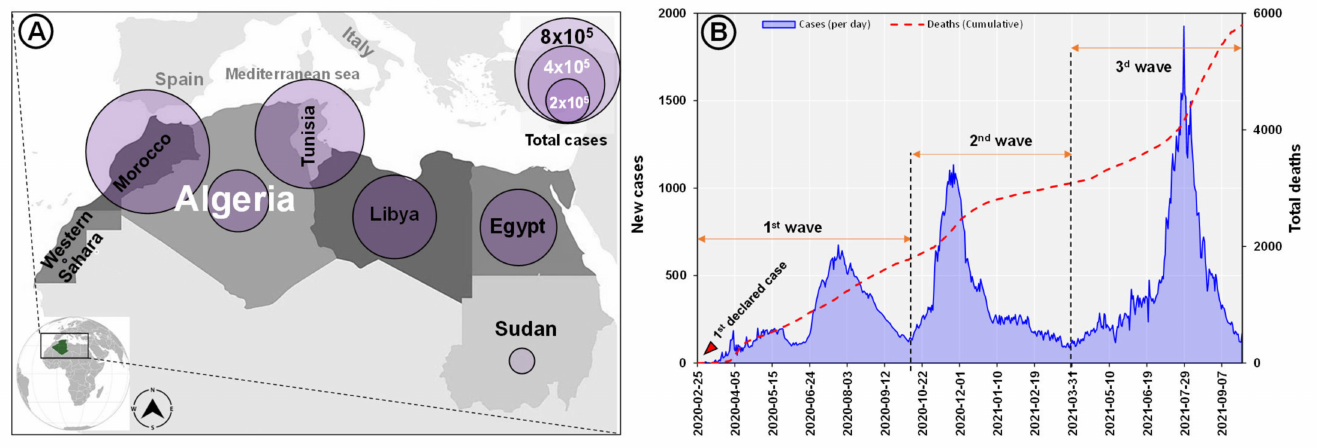
Figure 1. Total COVID-19 cases distribution in North African countries ( A ) and Algeria (daily new cases and cumulative deaths) (https://africacdc.org/covid-19/ accessed on 20 December 2021), ( B ) Graph based on a data source available online at (https://covid19.sante.gov.dz/carte/) (accessed on 20 December